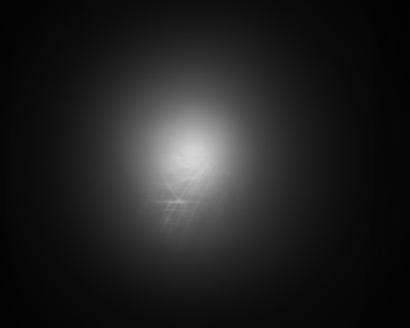
Figure 3. Illumination distribution correction image for 90% white panel image. Two different image correction algorithms were tested - Image difference and Image Product. Both of these algorithms use the illumination distribution correction image (C i ) to calculate illumination distribution correction coefficients (C c ) for each pixel, which is then either added or multiplied by the